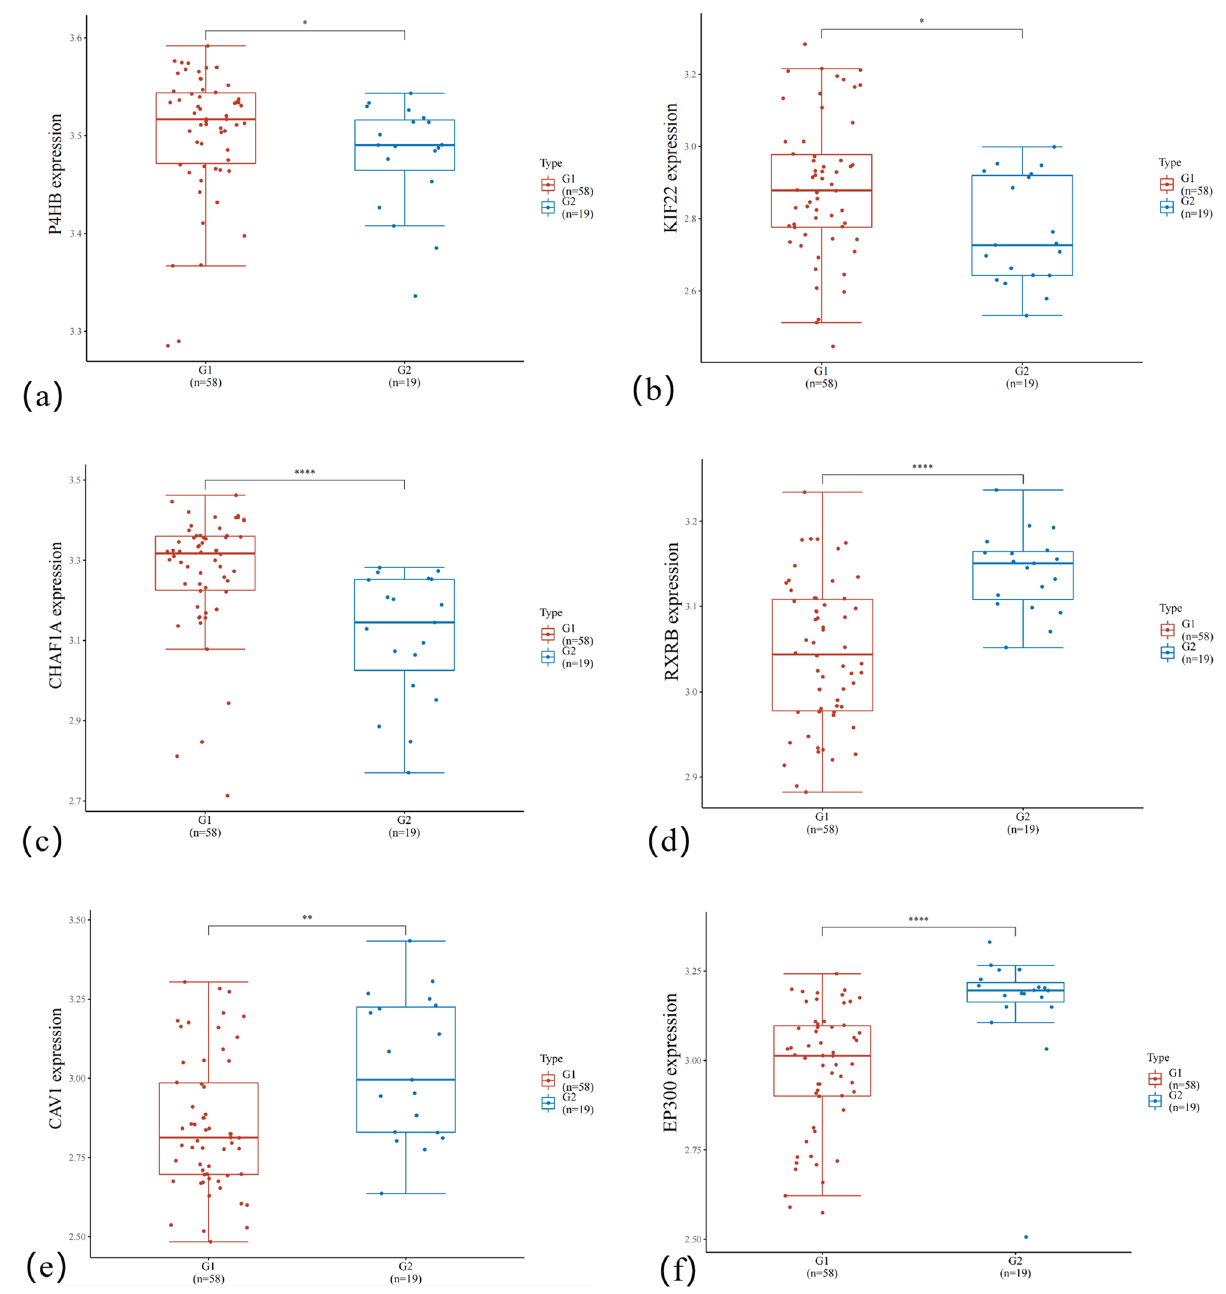
Figure 6. The expression distribution of genes in tissues, where figures ( a ) to ( f ) correspond to different genes, the horizontal axis represents different groups of samples (G1 represents positive samples and G2 represents negative samples), the vertical axis represents the gene expression distribution, where different colors represent different groups. Wilcoxon rank sum test is used here,* represents p < 0.05, ** represents p < 0.01, **** represents p <